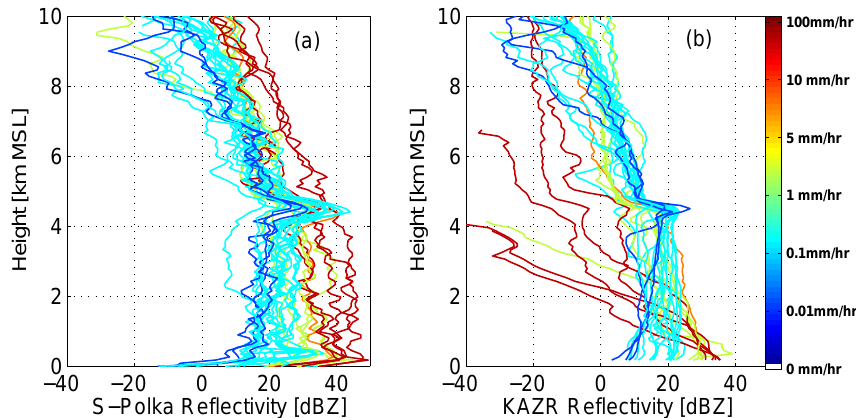
Figure 4. Illustration of rain-rate retrieval under a stratiform rain condition. (a) Reflectivity profiles of the S-PolKa for different rain rates. (b) Reflectivity profile of the KAZR for different rain-rates.